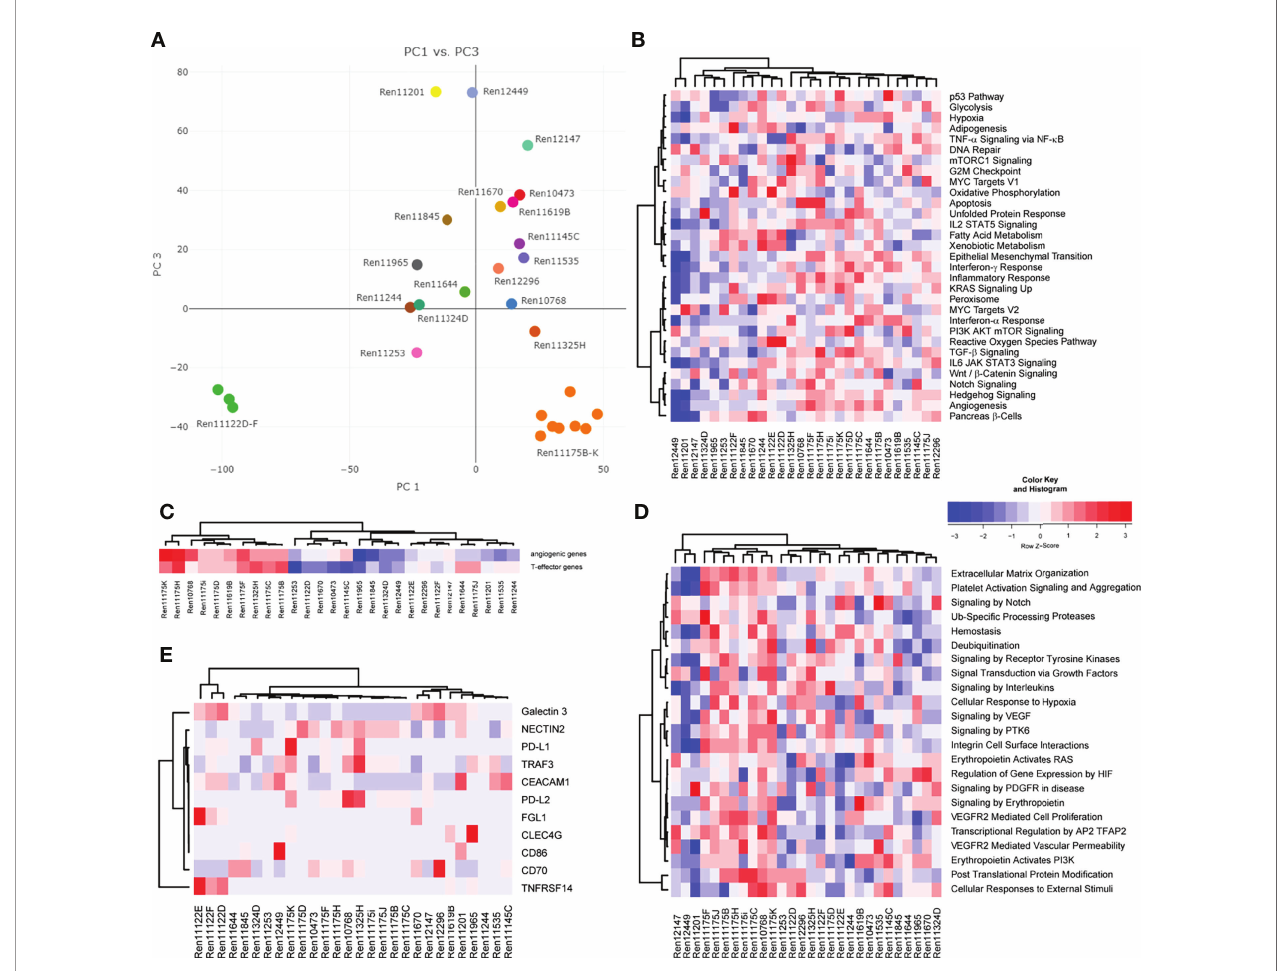
FIGURE 3 | Analysis of gene expression by RNA sequencing of PDX tumor tissue. (A) Representation of global gene expression in 28 molecularly characterized RCC PDX models by principal component analysis. The spatial distribution of samples re fl ects similarity of transcriptomes and correlates with clinical categorization of patient tumor tissue. Colors indicate individual donor patients. Similarity of RCC PDX models in gene set enrichment regarding cancer hallmarks (B) , the 66-gene signature distinguishing angiogenic or T-effector type (C) , and reactome pathways associated with VEGF and EPO function (D) are visualized by heat map and hierarchical clustering. (E) Relative expression of immune checkpoint ligands in the individual PDX tumors, visualized by heat map and hierarchical